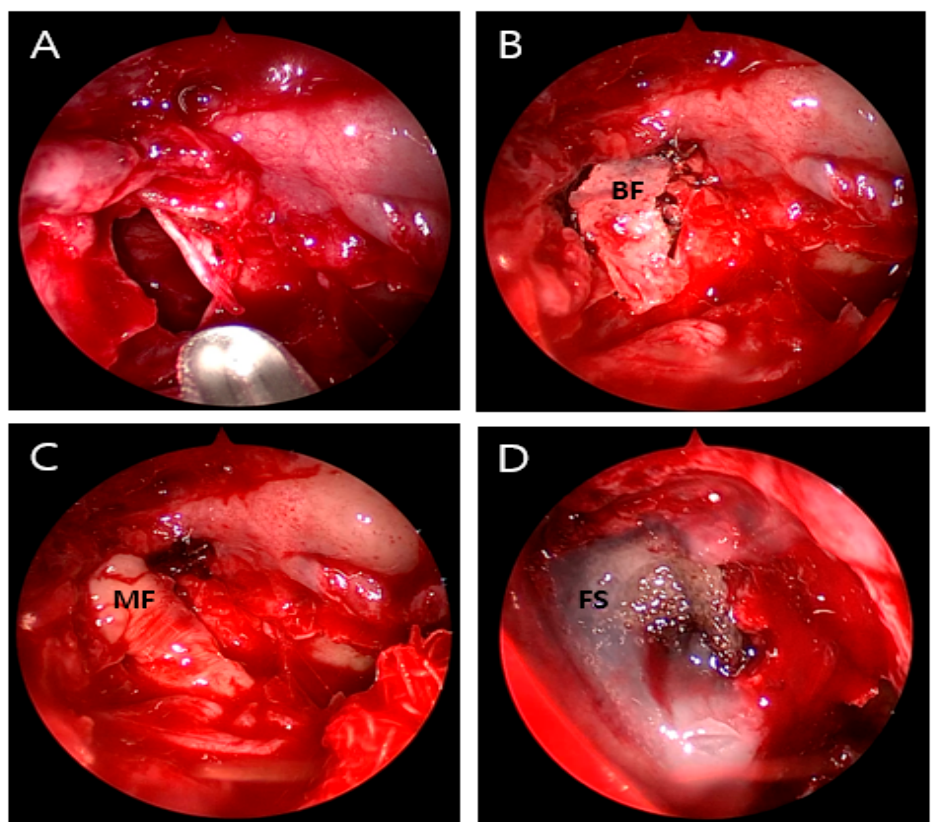
Figure 2. Intraoperative view images showing multi-layered closure of the dural and ethmoidal roof defect. ( A ) Bone defect (6 mm) on the horizontal (cribriform) plate of the ethmoid area. ( B ) Bone flap (indicated by ‘BF’). ( C ) Mucosal flap (MF). ( D ) Fibrin sealant (Evicel ® ) (FS).